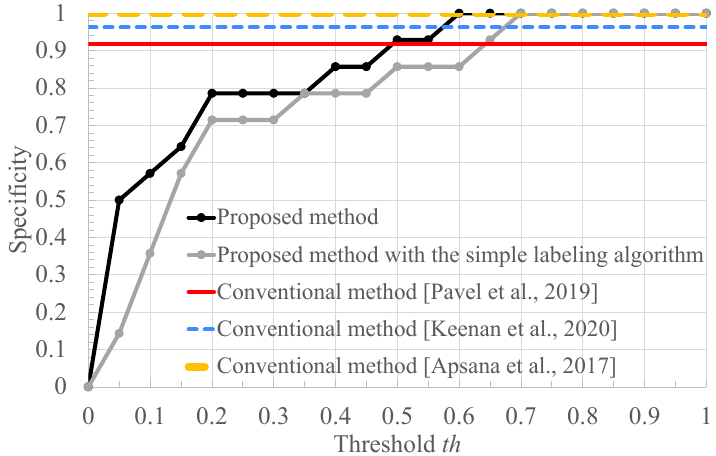
Figure 10. The specificity of the conventional methods [8–10], the proposed method with the simple labeling algorithm, and the proposed method.